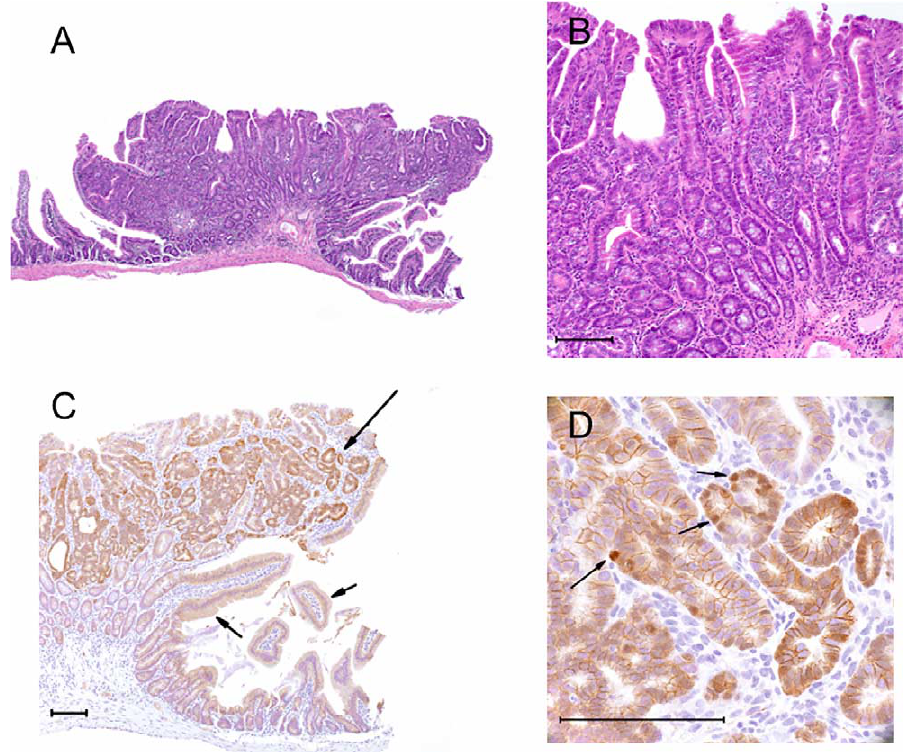
Fig. 1. (A) AOM-induced polypoid mass present in the small intestine; hematoxylin and eosin stain. (B) Higher magnification of tumor showing arrangement of cells in branching tubules; hematoxylin and eosin stain, bar = 100 µm. (C and D) Immunohistochemistry for β -catenin using DAB as chromogen and Mayer’s hematoxylin as counterstain; all bars = 100 µm. (C) note light staining of normal epithelium (short arrows) compared to more intense staining of tumor (indicated by long arrow). (D) Higher magnification showing prominent nuclear staining for β -catenin (see arrows) in addition to cytoplasmic